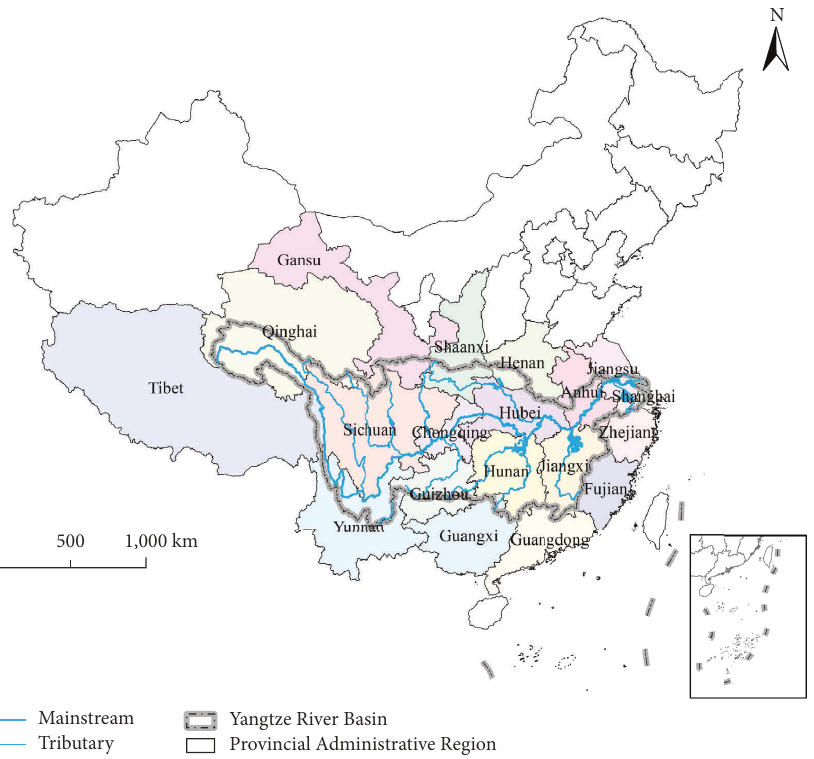
Figure 1: Overview map of